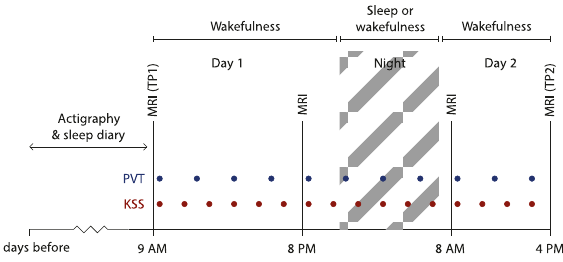
Fig. 1 Overview of the study protocol. Participants underwent MRI including T 1 w- and T 2 w scans in the morning after a night of sleep (time point (TP)1) and then in the afternoon on the second day (TP2) after 32 h of either normal sleep-wake or total sleep deprivation. They also underwent MRI (not including T 1 w- and T 2 w scans) in the evening on the fi rst day and in the morning on the second day. During the study, participants underwent tests of subjective sleepiness (Karolinska Sleepiness Scale, KSS) and objec- tive alertness (Psychomotor Vigilance Task, PVT) every second and third hour, respectively. Seven days prior to the fi rst MRI scan, participants underwent measurements of sleep habits by actigraphy and self-report sleep